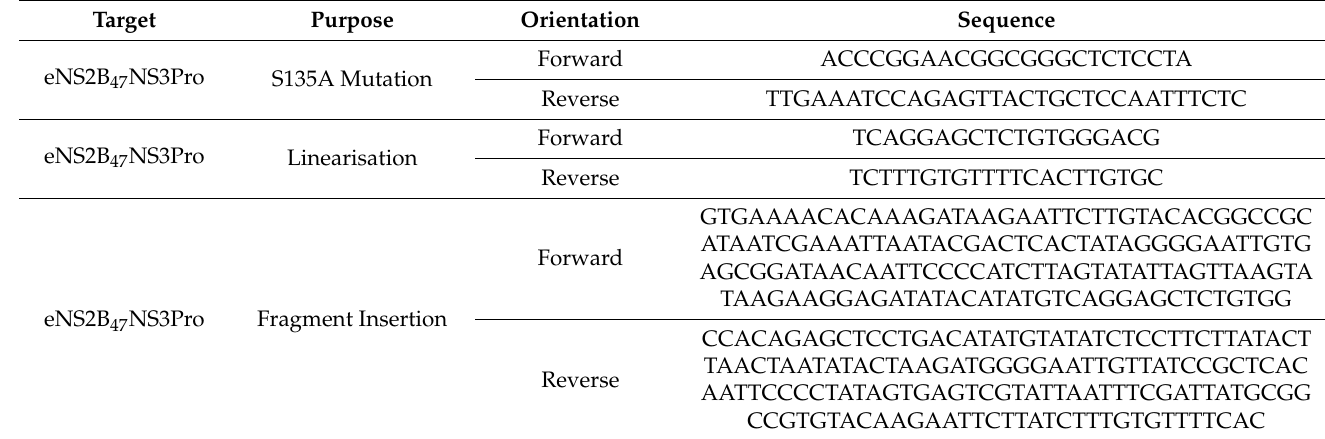
Table 2. Primers used in the